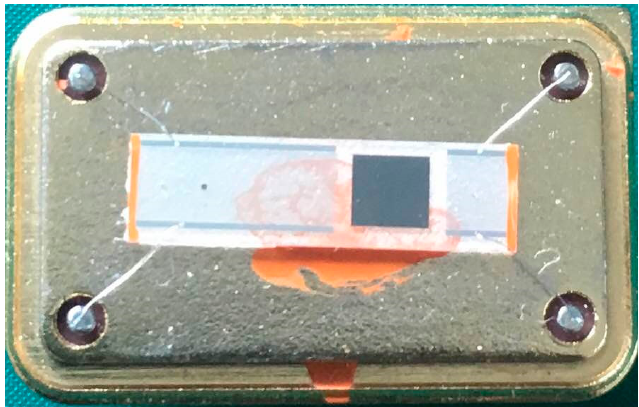
Figure 7. The physical picture of developed sensor chip, FeNi thickness: 500 nm, aspect ratio: 1:1.